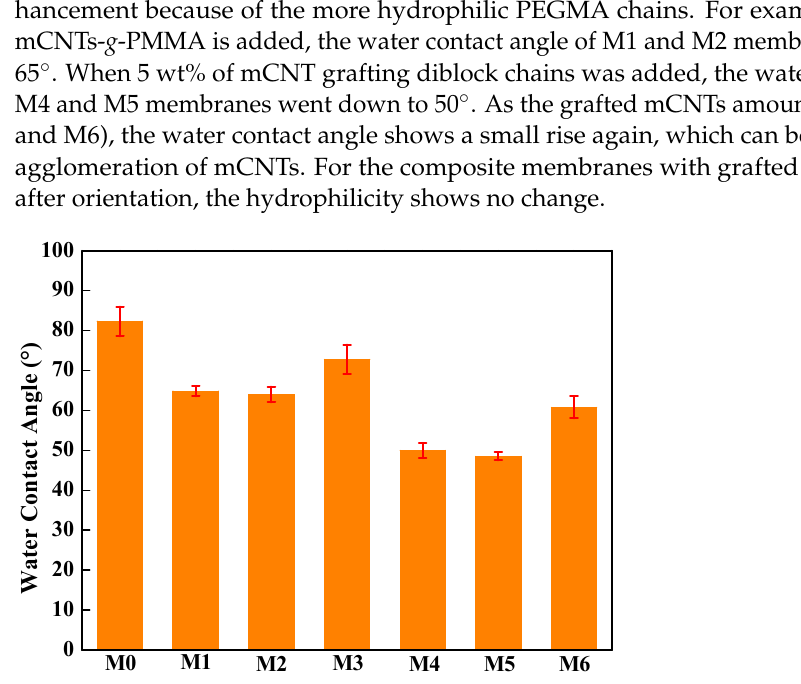
Figure 8. FITR spectra of PVDF composited membranes with oriented or unoriented mCNTs graft- ing single and diblock chains and membranes with oriented or unoriented mCNTs. When the mCNTs grafting diblock chains are added to the PVDF membrane (M4, M5 and M6), only β -PVDF exists in the crystalline phase. This result confirms that the mCNT grafting diblock chains favor the β -PVDF formation during the membrane preparation, the reason why higher melting peaks are obtained in the M4 and M5 samples (Figure 5).